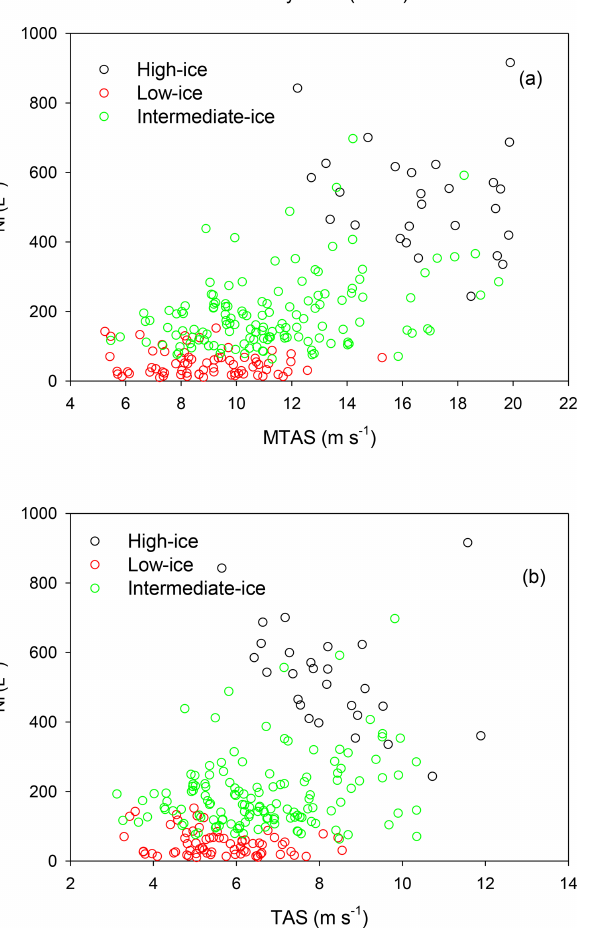
Figure 10. Relationships between maximum 1s TAS (MTAS) (a) and 1min average TAS (b) and N i for high-ice, low-ice, and intermediate-ice (all other 1min periods) periods on 9 Febru- ary 2014.